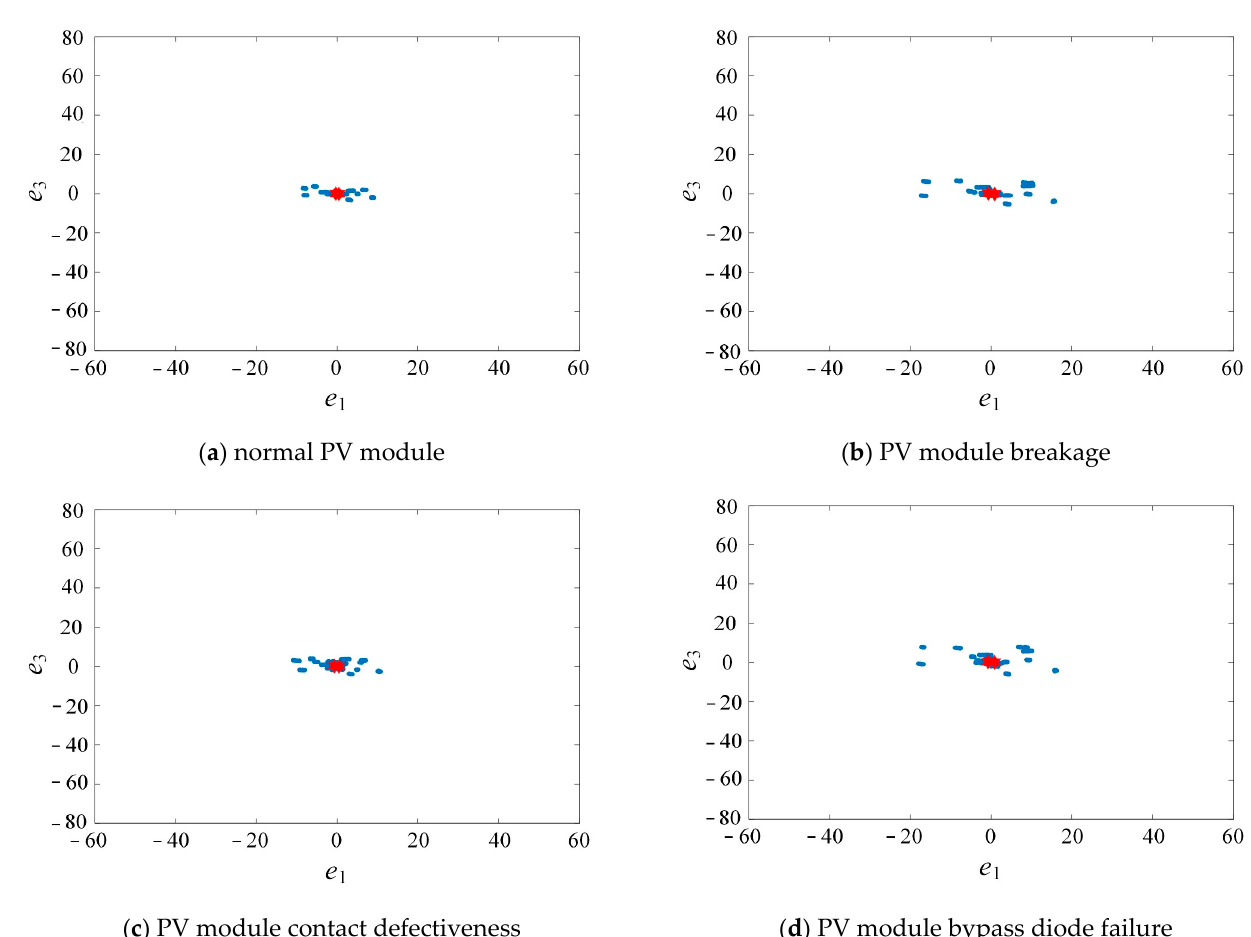
Figure 18. Normalized chaotic dynamic error map ( e 1 e 3 ) of PV module fault types.